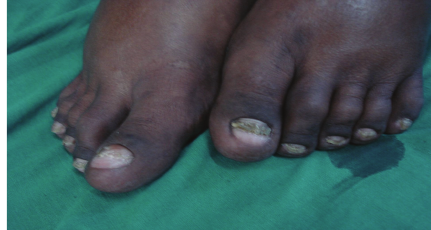
Figure 3: Hyperpigmentation in hands.